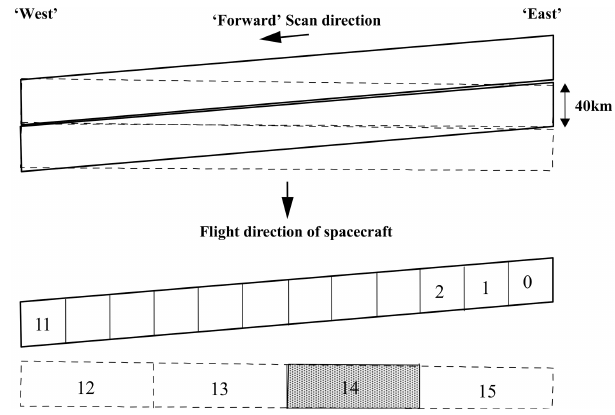
Figure 5. Scan pattern in default scan mode. Solid line: forward scan; dashed line: fly back. Each subset pixel (0–15) corresponds to 375ms. In one of the four subsets of the fly back (subset 14 is shown as an example only) the “unused” parts of the PMD detectors (i.e. block A; see Appendix B of EUMETSAT, 2014a) are read